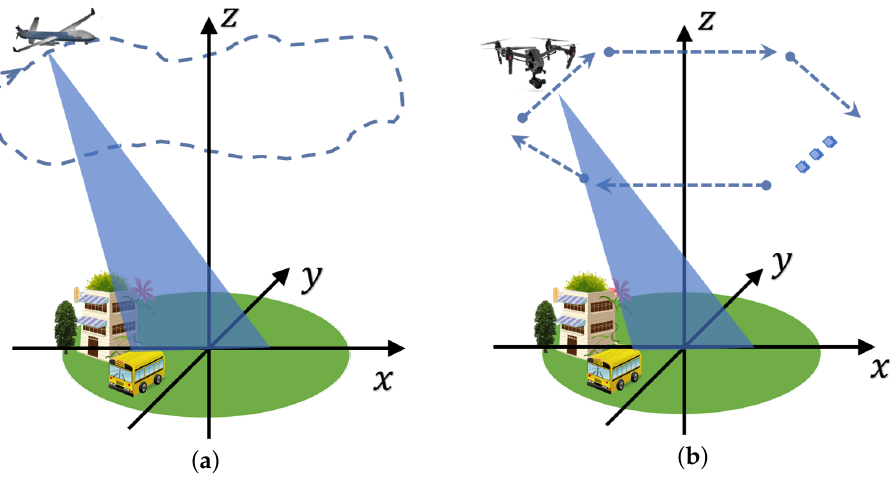
Figure 1. Multi-aspect SAR data collection geometry. ( a ) Circular trajectory. ( b ) Polygon